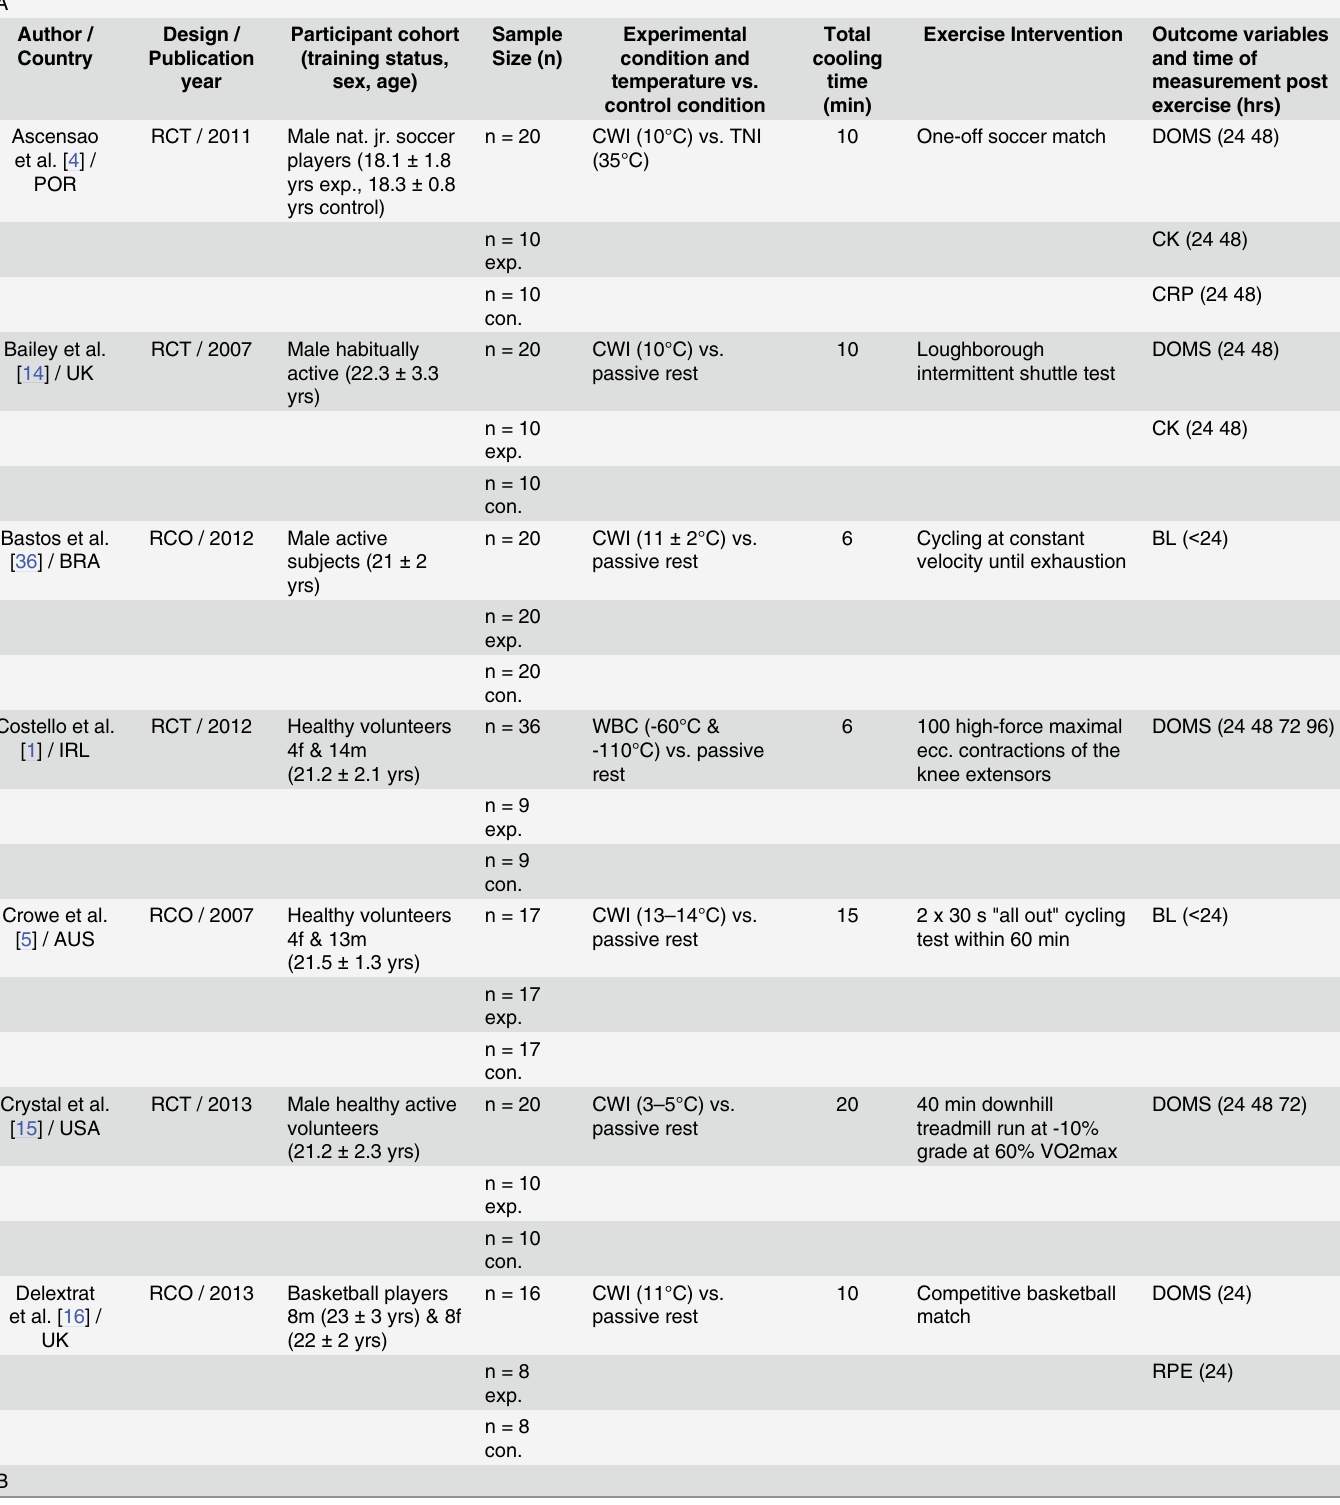
Table 1. Summary of the used studies for the